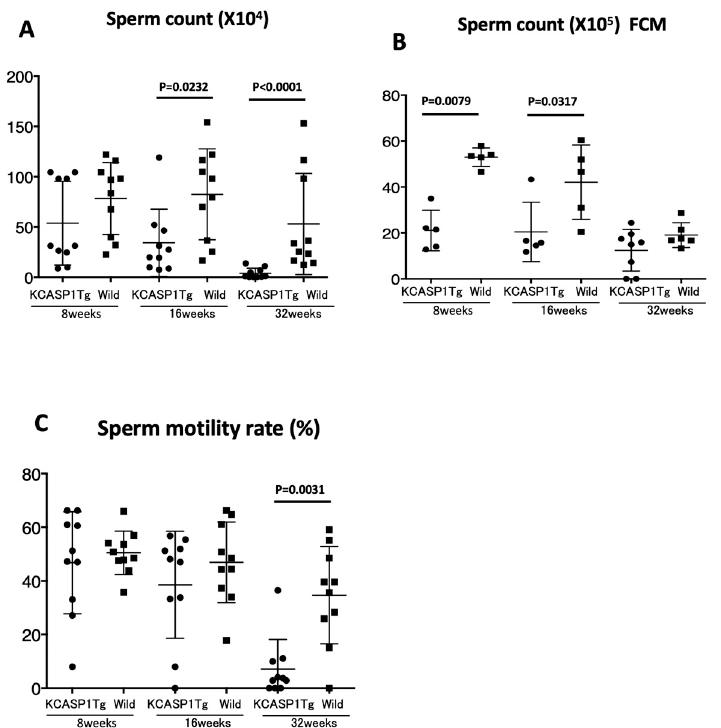
Figure 4. Sperm count and sperm motility. Sperm count was measured with two different methods. By using a Makler sperm count chamber under the direct microscopic observation, a significant decreased sperm count was detected at 16 and 32 weeks of KCASP1Tg mice ( p = 0.0232 and p < 0.0001, respectively, A ). Flow cytometry (FCM) analysis also revealed a decreased sperm count at 8 and 16 weeks of KCASP1Tg mice ( p = 0.0079 and p = 0.0317, respectively, B ). The sperm motility ratio was significantly decreased at 32 weeks of KCASP1Tg mice compared to wild-type controls ( p = 0.0031, C ).